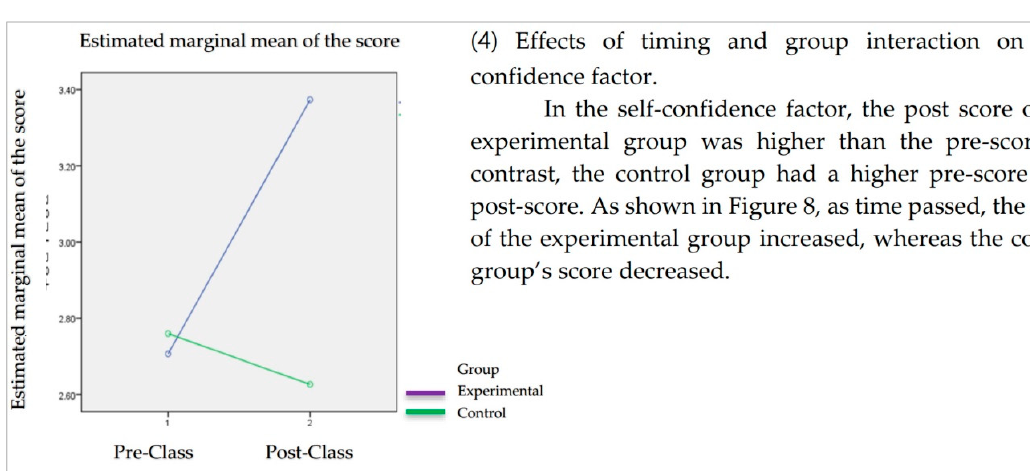
Figure 7. Effect of timing and group interaction on Adequacy.